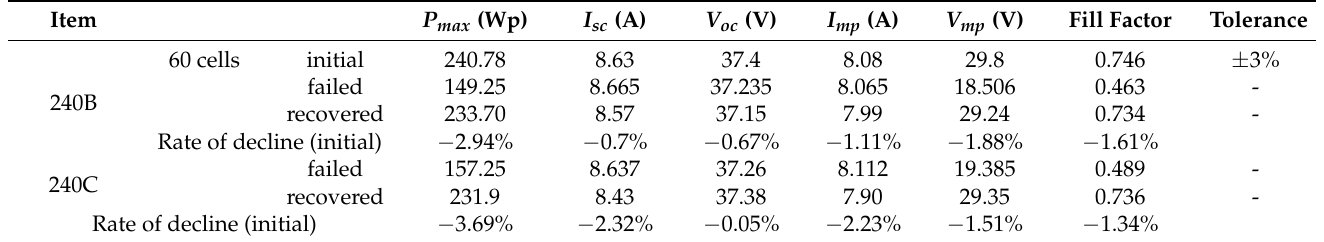
Table 6. Electrical data deviations of the initial, failed, and recovered modules. (240B and